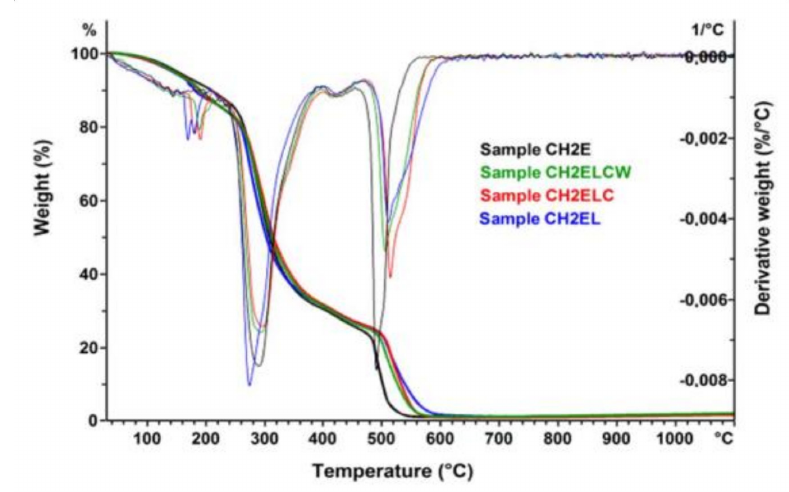
Figure 9. TG and DTG curves of chitosan/starch − based